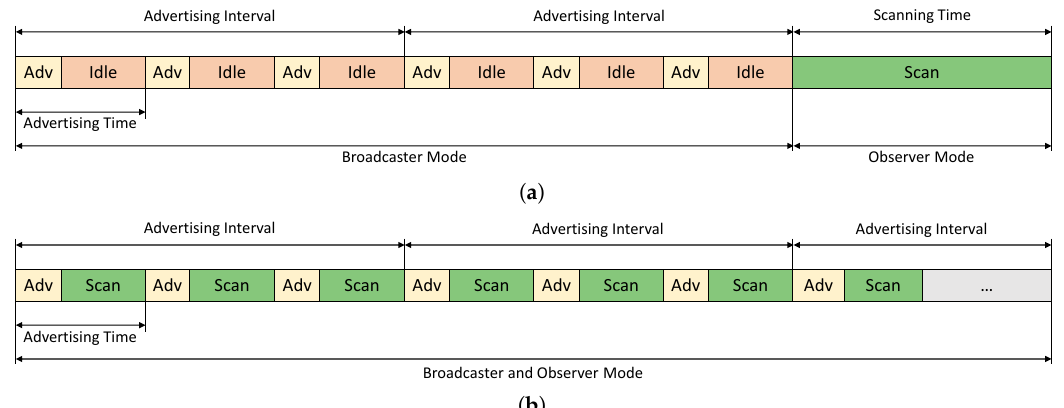
Figure 12. Differences between Advertising and Scanning processes in BLE version 4.0 and 4.1. ( a ) Advertising and Scanning processes in BLE 4.0; ( b ) Advertising and Scanning processes in BLE